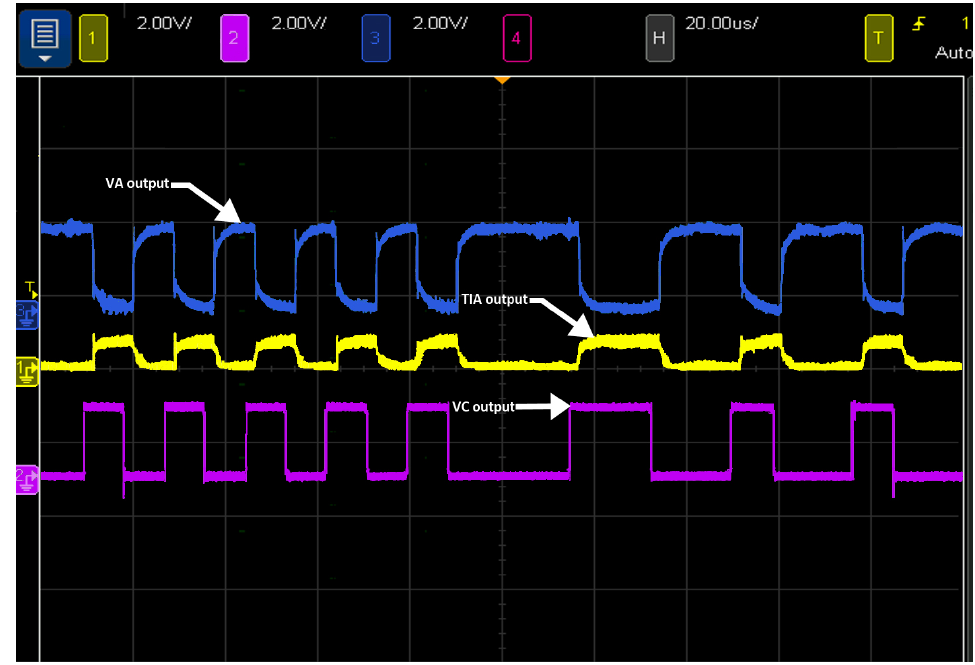
Figure 5. Output waveforms of the TIA, GC, and LPF.